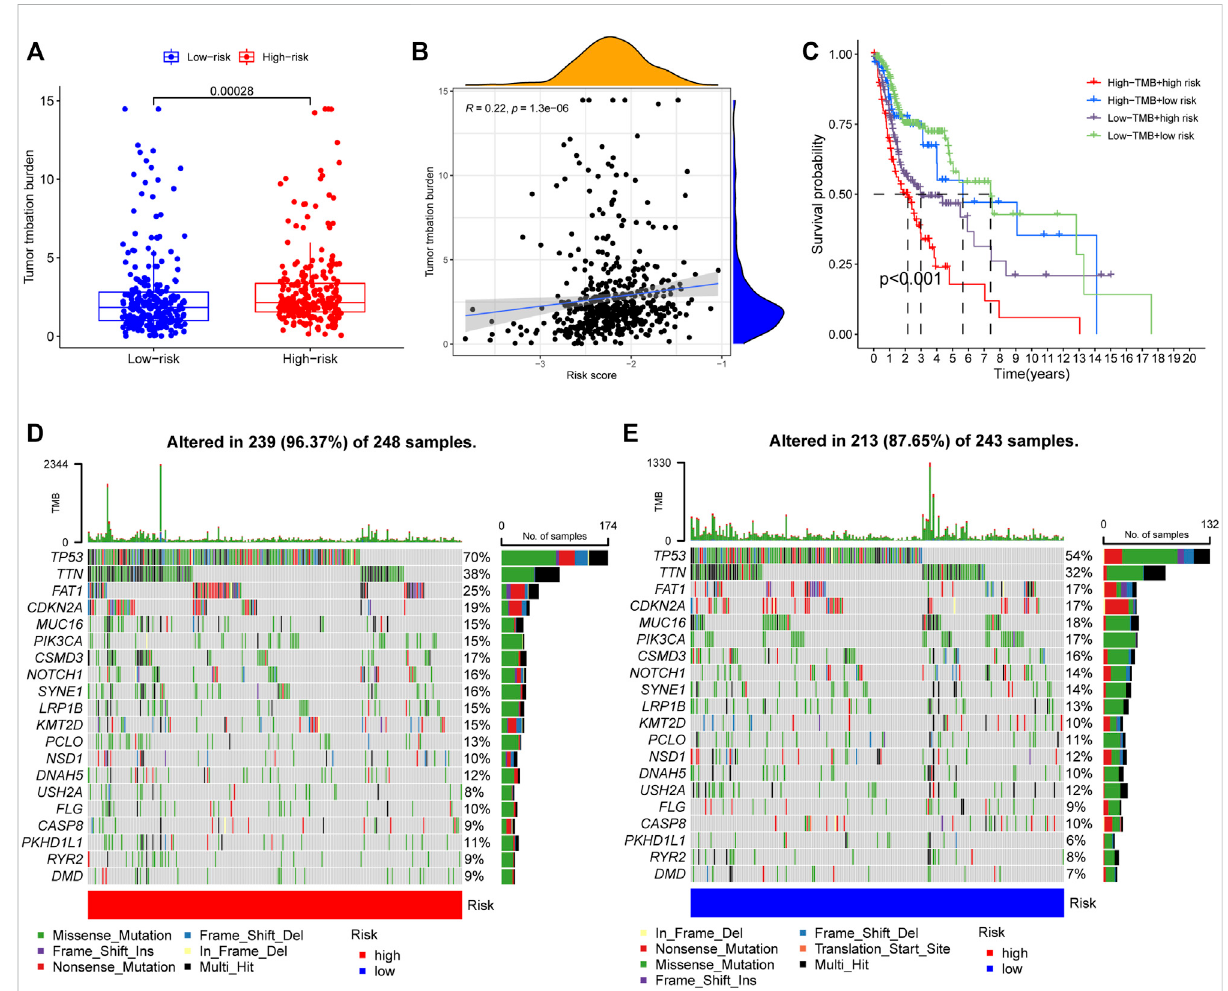
FIGURE 15 (A) TMB difference among the high and low risk groups. p = 0.00028. (B) The Spearman correlation analysis between risk score and TMB. r = 0.22, p = 1.3e-06. (C) K-M survival analysis strati fi ed by both TMB and risk scores. p < 0.001. (D,E) Distribution of the top 20 variant mutated genes among high (D) and low (E) risk groups. The waterfall plot showing the genetic alterations